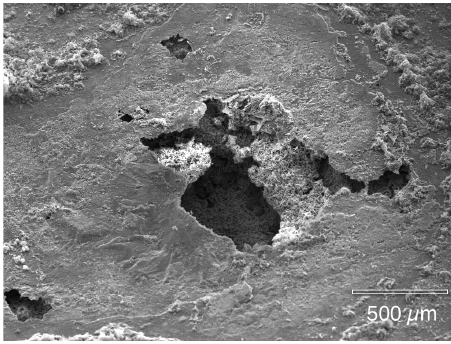
Figure 7. When the cuprite membrane was fractured, the larger underlying pit cavity was seen.